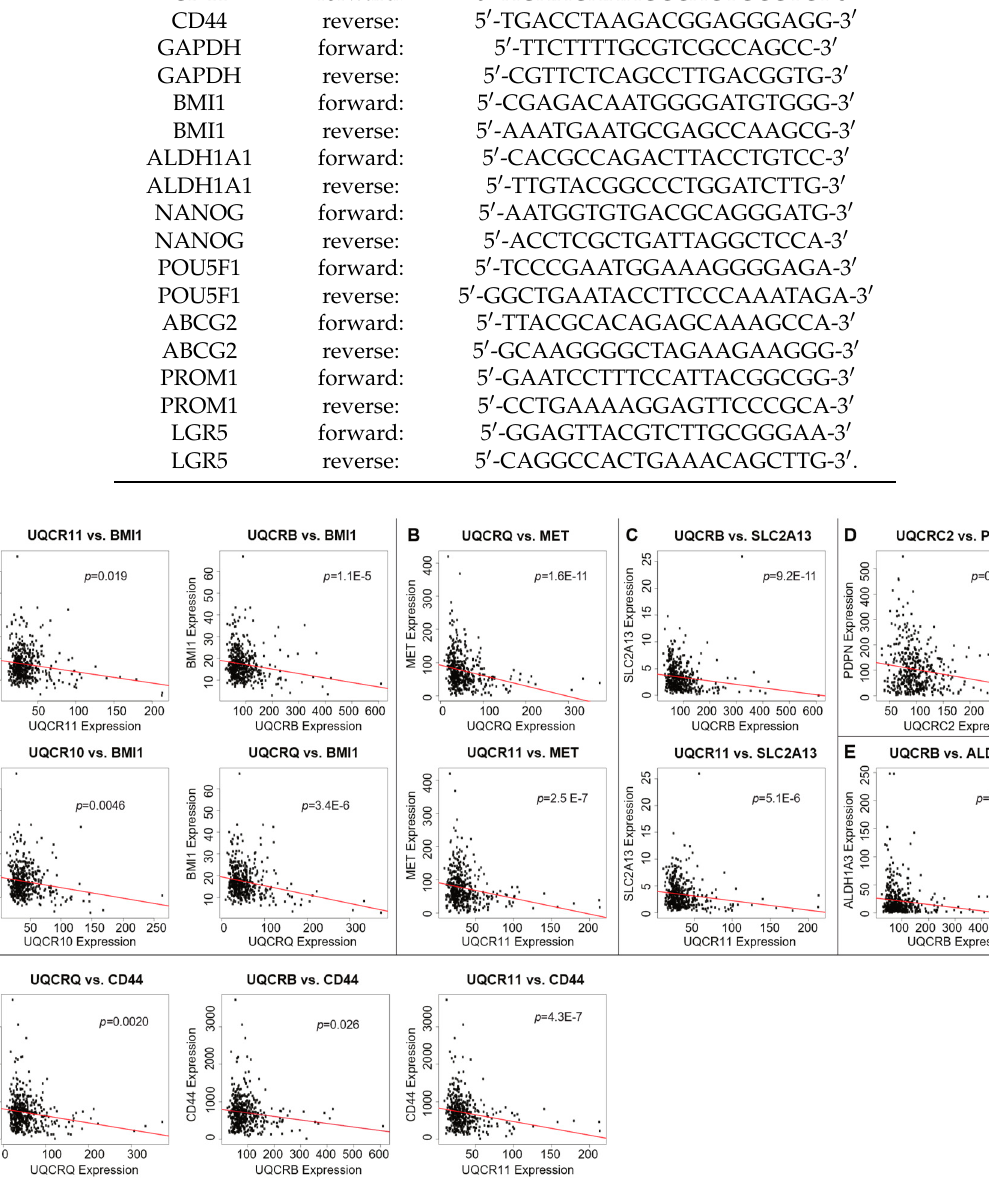
Figure 5. Scatter plots of complex III subunits’ expressions vs. expressions of various stem cell markers: ( A ) BMI-1, ( B ) MET, ( C ) SLC2A13, ( D ) PDPN, ( E ) ALDH1A3, and ( F ) CD44. Correlations were performed with Spearman’s correlation test ( p < 0.05). Table 1. Primer sequences used for quantitative PCR.